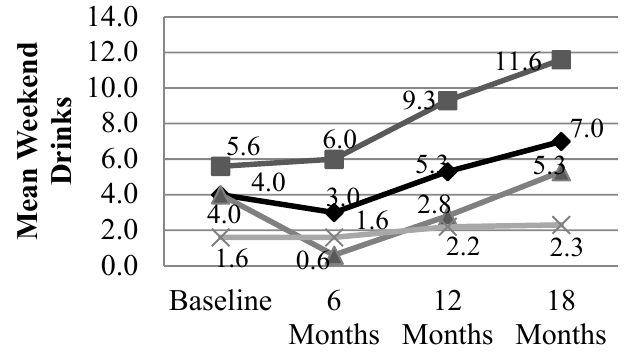
Figure 5. Total happiness score and weekend drinking at baseline, 6, 12, and 18 months. Data include only those women pregnant at baseline who have data for all four time periods ( n = 50); Repeated measures analysis, within- Ss effect, time: F = 3.784, p = 0.058; Repeated measures analysis, within- Ss effect, time x group: F = 1.288, p = 0.285; Repeated measures analysis, between- Ss effect, group; F = 5.589, p = 0.007.